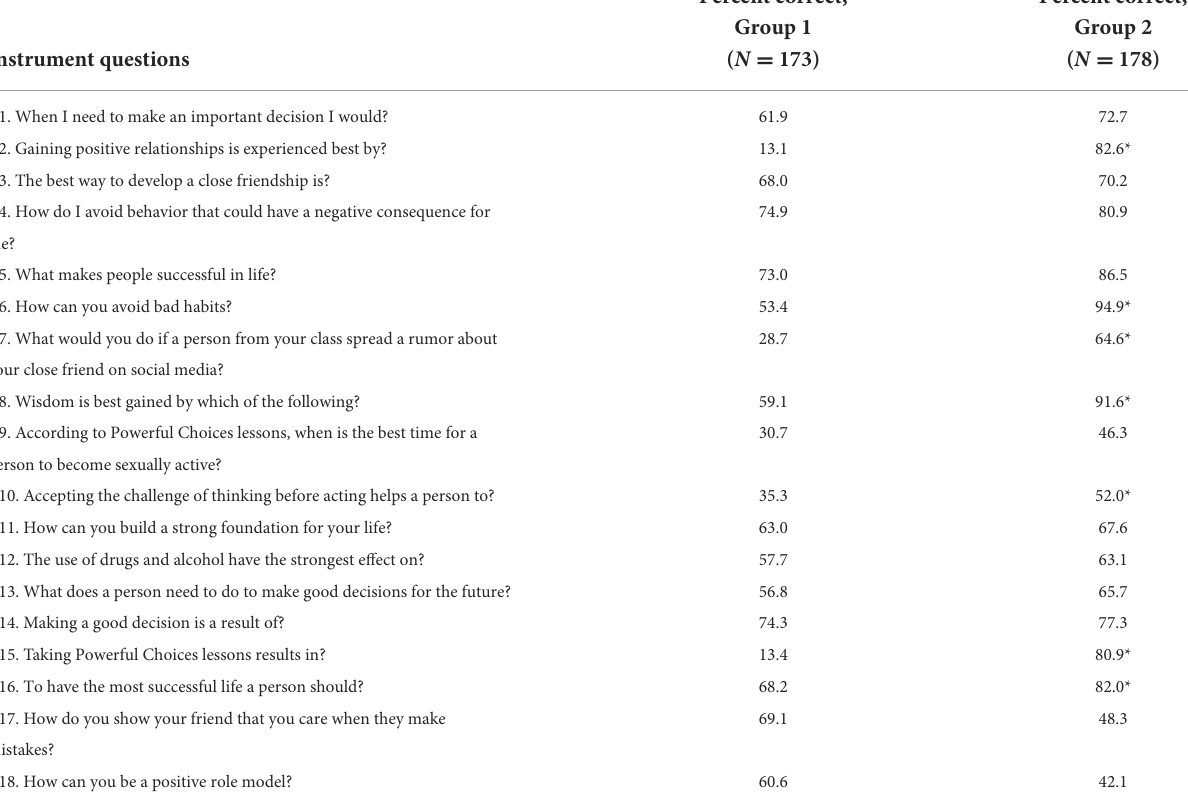
Percent correct, Group 1